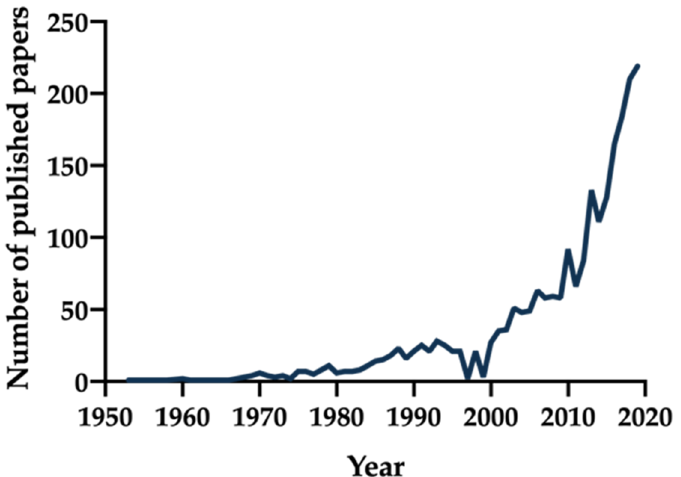
Figure 1. Number of publications over the years using as search terms “long acting injectable”, “long acting parenteral”, “long acting depot”, “depot formulation”, “sustained release parenteral”, or “controlled release parenteral” via a PubMed inquiry by year [6].